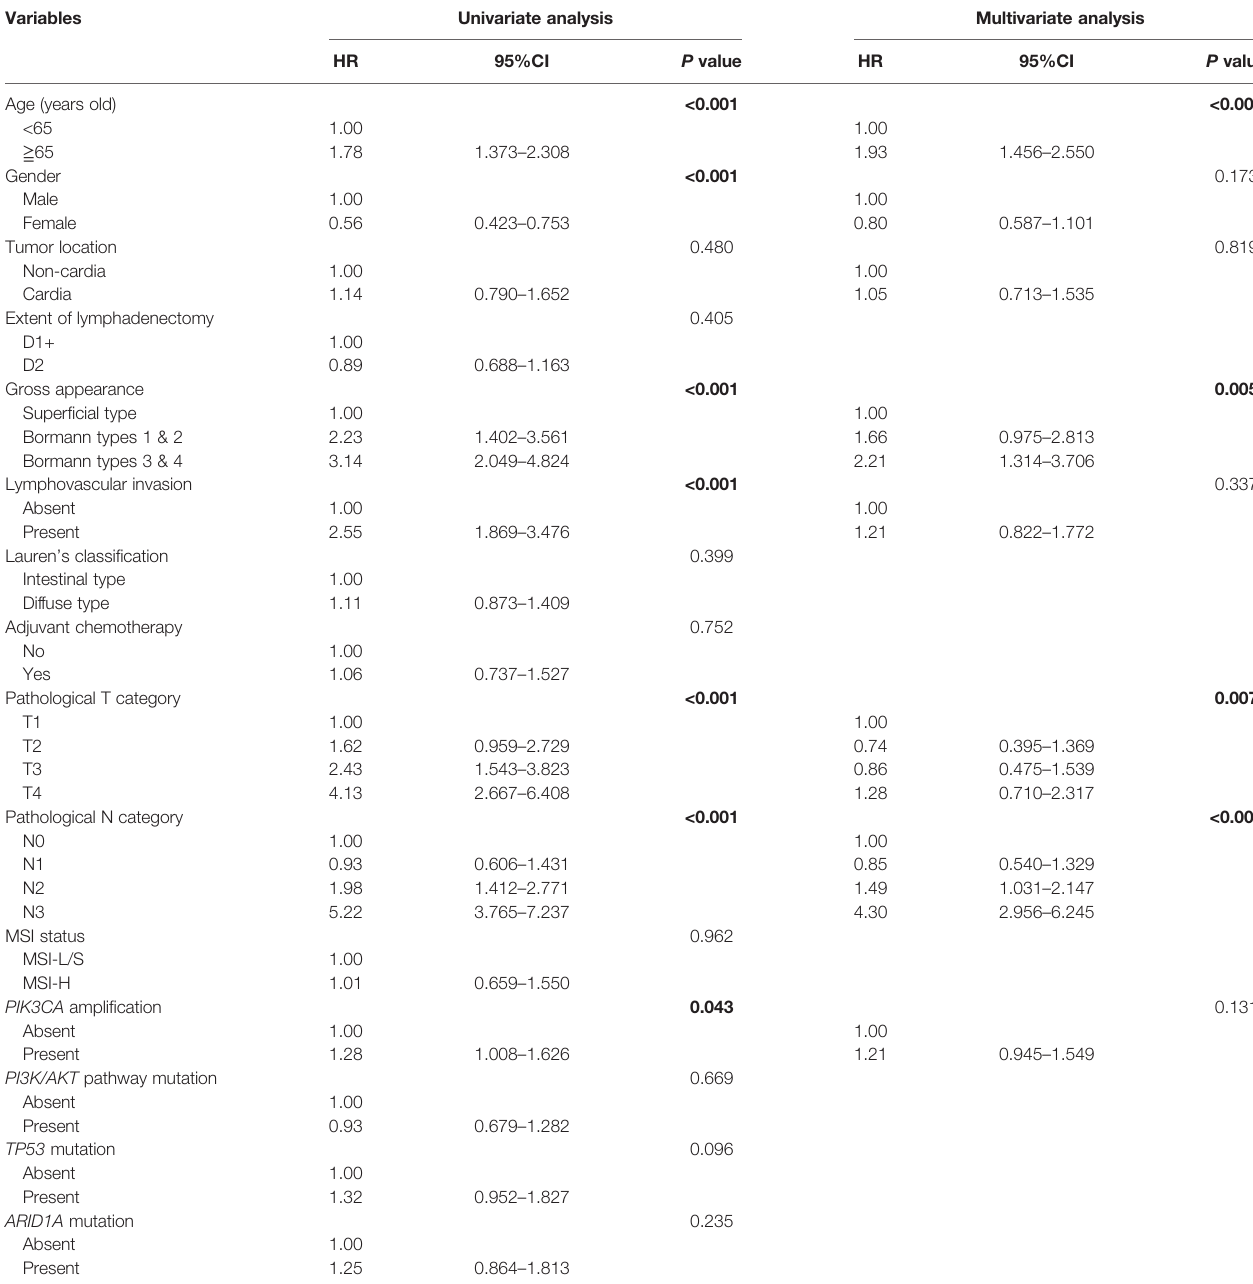
TABLE 4 | Univariate and multivariate analysis of factors affecting OS of GC patients after curative surgery.